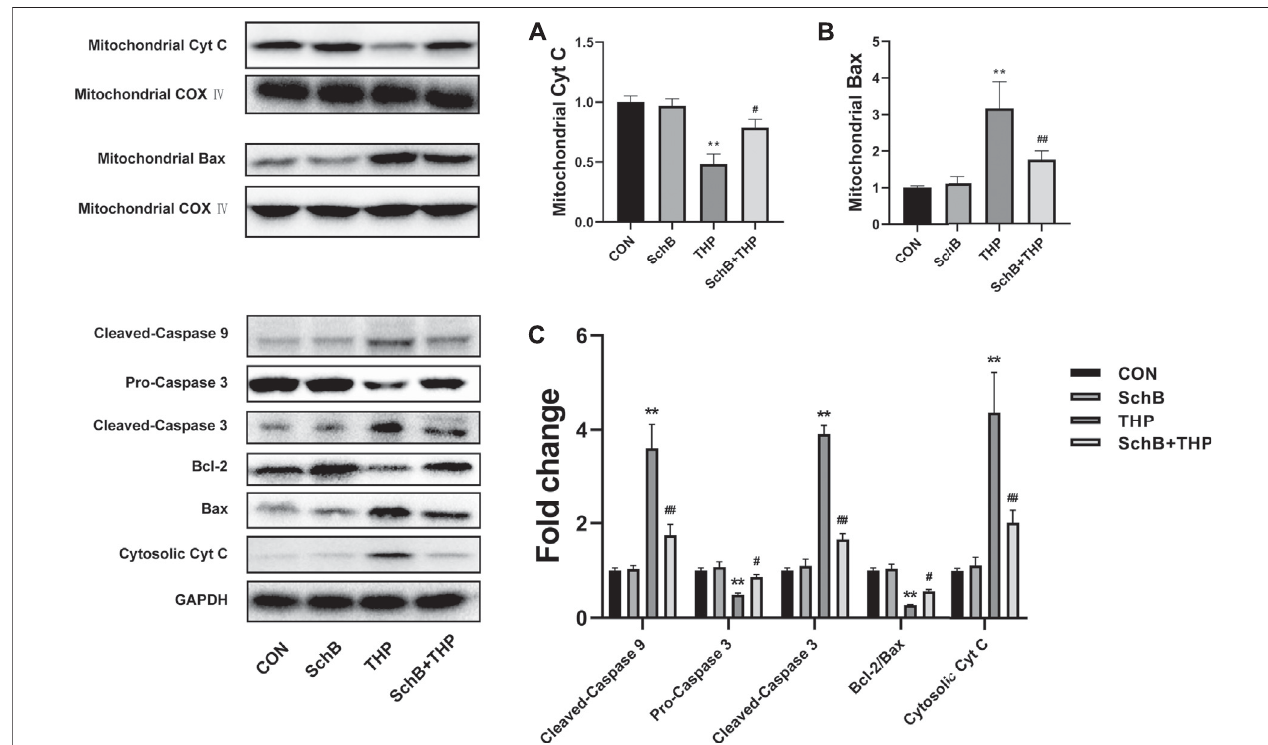
FIGURE5 | SchB ameliorates THP-induced abnormalexpression of apoptosis-relatedproteins inrat heart. The content ofmitochondrial Cyt C (A) decreased and Bax (B) increasedintheTHPgroup,butreversedintheSchB+THPgroup (C). IntheTHPgroup,theexpressionofcytosolicCytCandcleaved-caspase9/3increased, while procaspase 3 and Bcl-2/Bax ratio decreased. The above changes were reversed in the SchB + THP group. More evidence can be found in the semiquantitative analysis (A – C) . All values are mean ± SD. *p < 0.05 vs. CON , ** p < 0.01 vs. CON , # p < 0.05 vs. THP , and ## p < 0.01 vs. THP .